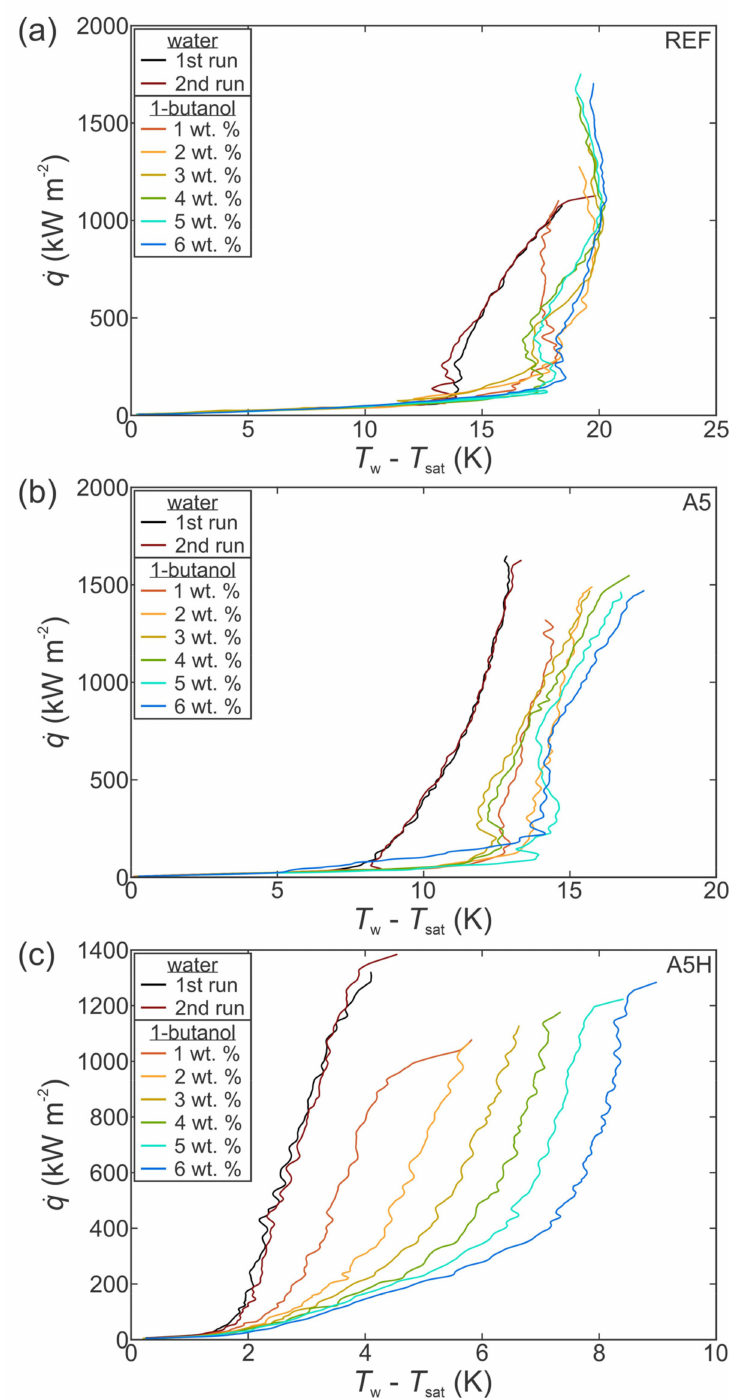
Figure 7. Boiling curves for 1-butanol mixtures with 0–6 wt.% of butanol recorded on the untreated reference surface REF ( a ), etched hydrophilic surface A5 ( b ) and hydrophobized etched surface A5H ( c